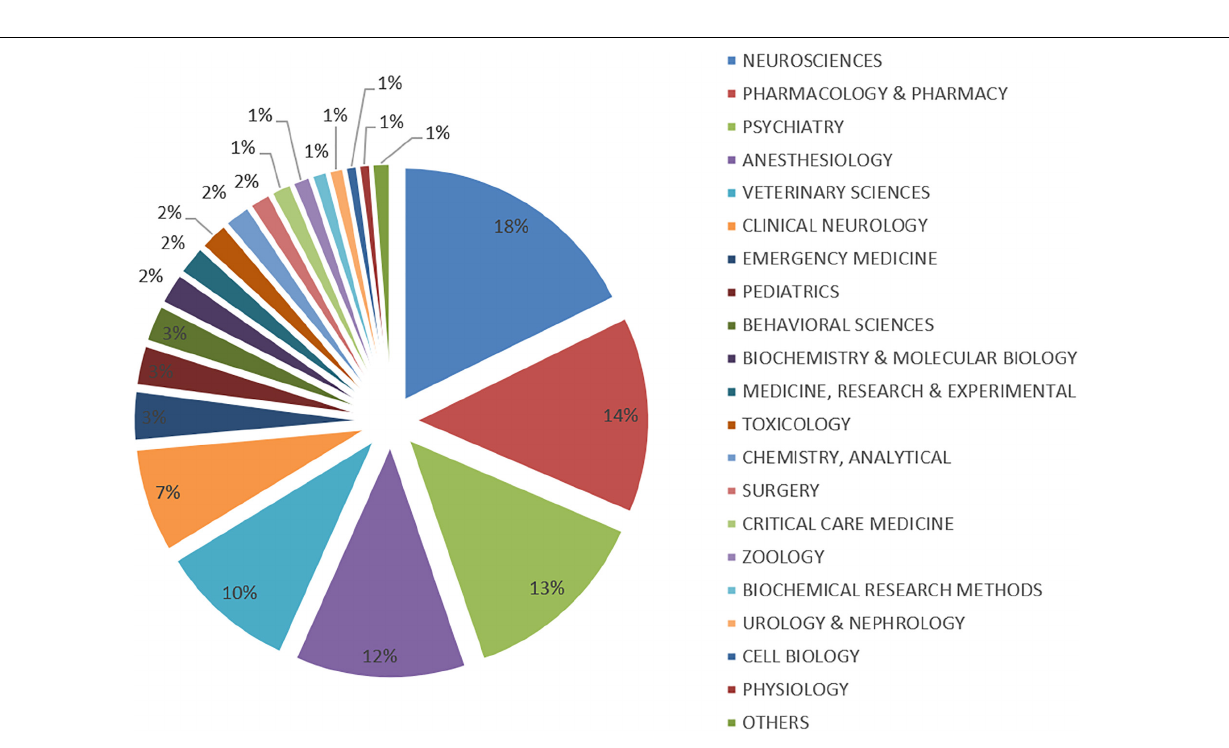
FIGURE 3 | The proportion of articles published in different